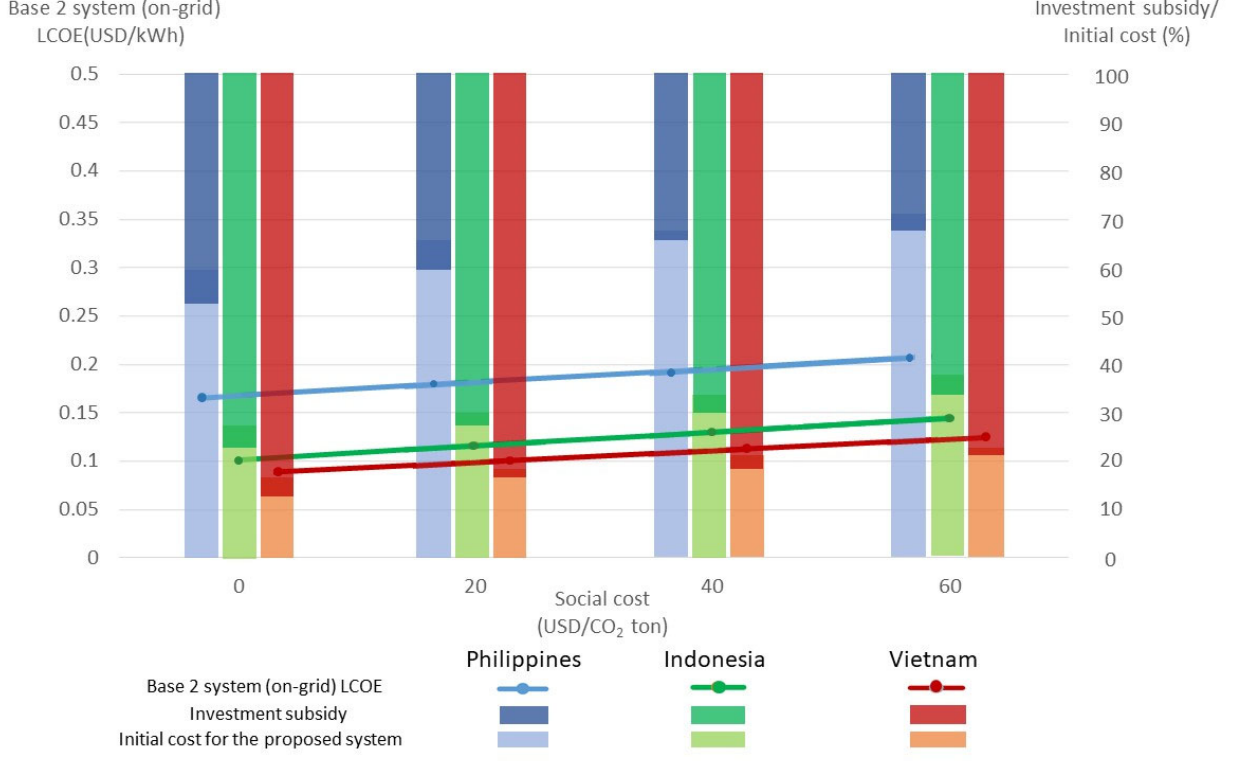
Figure 8. Calculation of grid parity level in the three countries by investment adjustment + incorpo- ration of social cost (GHG emissions).